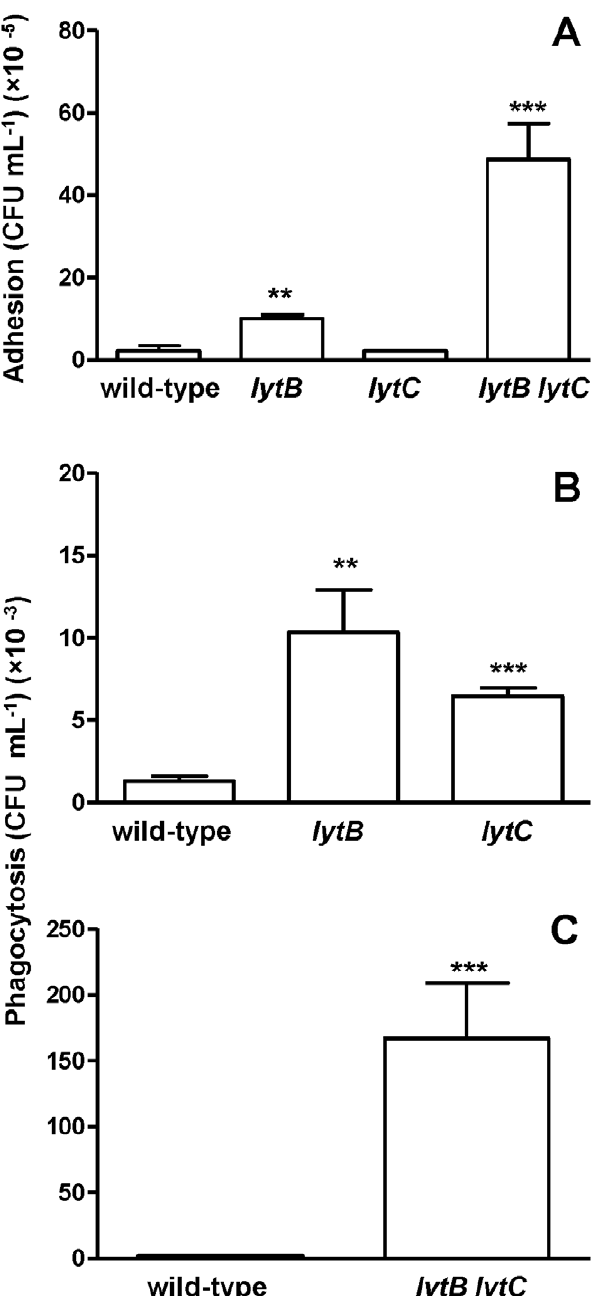
Figure 4. Phagocytosis mediated by murine alveolar macro- phages. (A) Adhesion of D39 wild-type strain and lytB , lytC and lytB lytC strains to alveolar macrophages. (B and C) Phagocytosis of the wild-type D39 and CWHs defective strains by alveolar macrophages. Error bars represent the SDs and asterisks indicate statistical significance compared to the wild-type strain (two-tailed Student’s t test; *, P , 0.05; **, P , 0.01; ***, P , 0.001). P , 0.05 and P , 0.01 for the comparison of the results in adhesion and phagocytosis for lytB lytC vs. lytB or lytC respectively. P , 0.001 for the overall comparison in phagocytosis (one-way ANOVA with a post hoc Dunnett test). doi:10.1371/journal.pone.0023626.g004 were calculated as a CI for bacteria recovered from BALF, lung, and blood. Loss of LytB did not show impaired virulence at any of the target sites analyzed confirming that the single mutation of